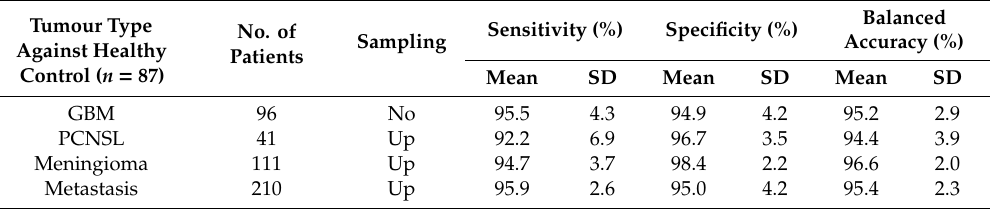
Table 1. Summary of partial least squares-discriminant analysis (PLS-DA) results for brain tumours against controls. Sensitivity, specificity and balanced accuracy are reported as means and standard deviations (SD) calculated over 100